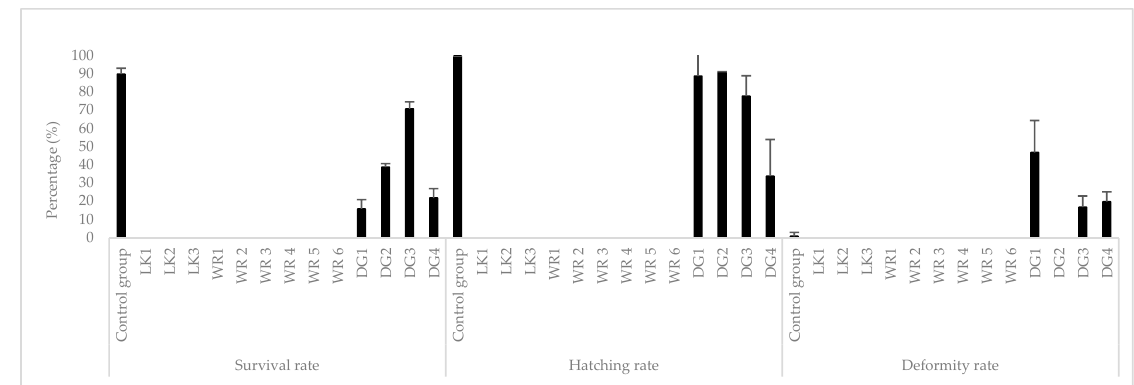
Figure 5. Toxic effects on survival, hatching rate, and deformity rate of zebrafish embryos of river sediment porewater from different sampling sites in Pingtung city. Error bars represent standard deviations (n = 3).